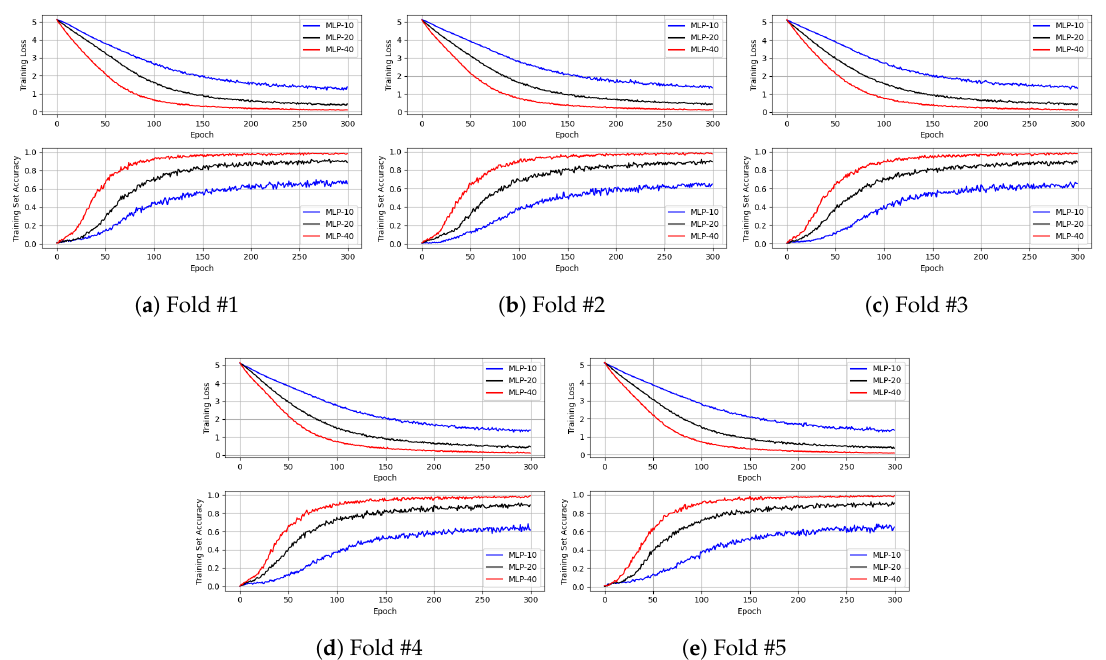
Figure 14. Training loss and training set accuracy of each MLP over 5-fold cross-validation.